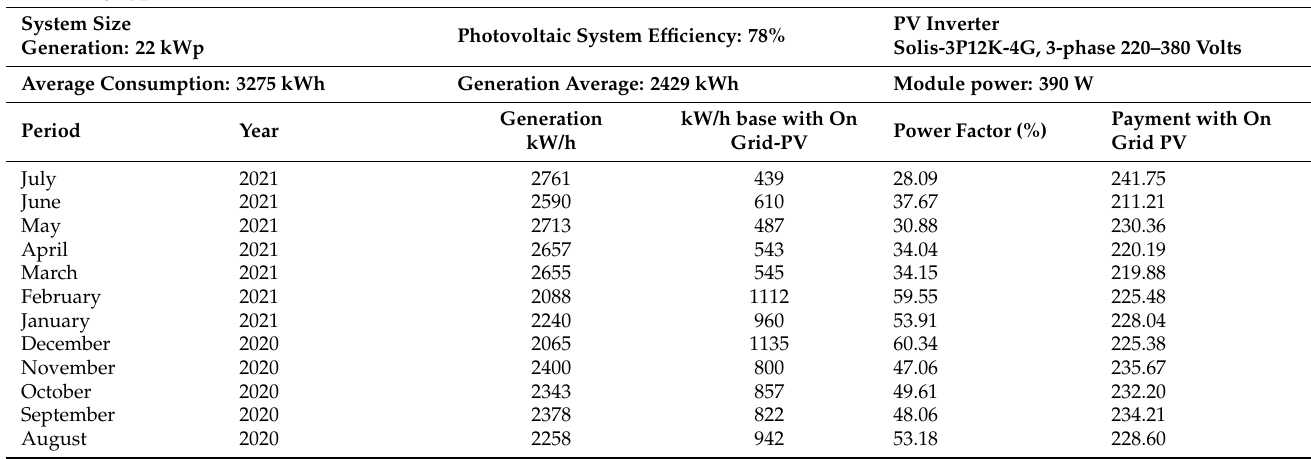
Table 6. Estimated generation of the On Grid-PV system.